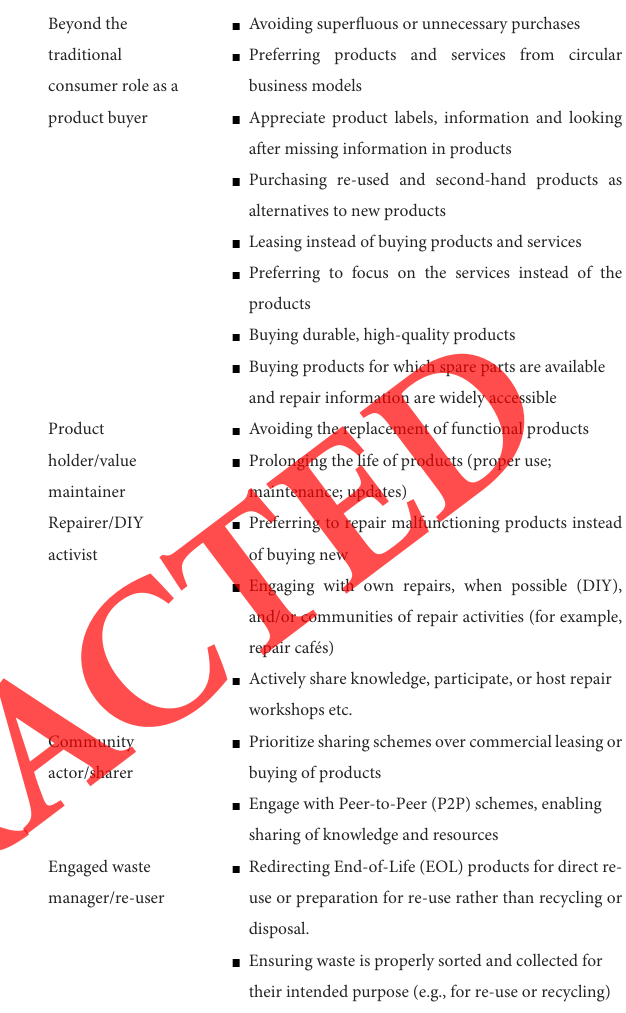
TABLE 1 Mapping the roles of citizens in the CE [Adapted from (Maitre-Ekern and Dalhammar,